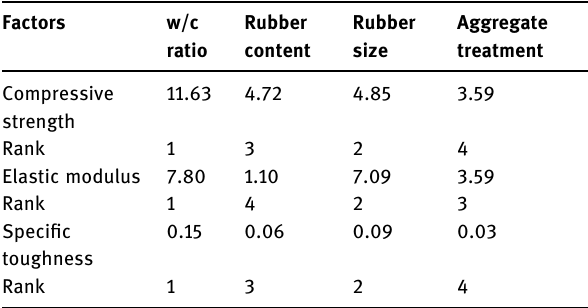
Table 10: Standard error of three levels of each